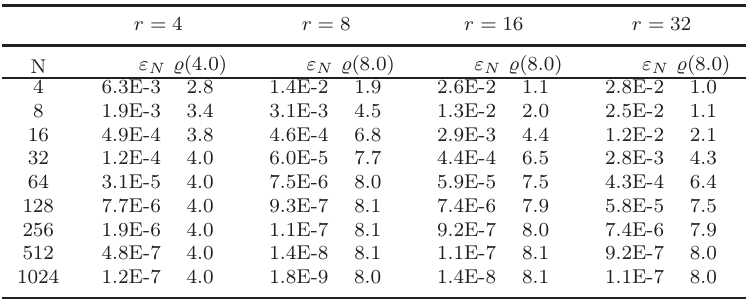
Table 2. Numerical results, numerically computed system integrals. r = 4 r = 8 r = 16 r = 32 N ε N ̺ (4.0) ε N ̺ (8.0) ε N ̺ (8.0) ε N ̺ (8.0)